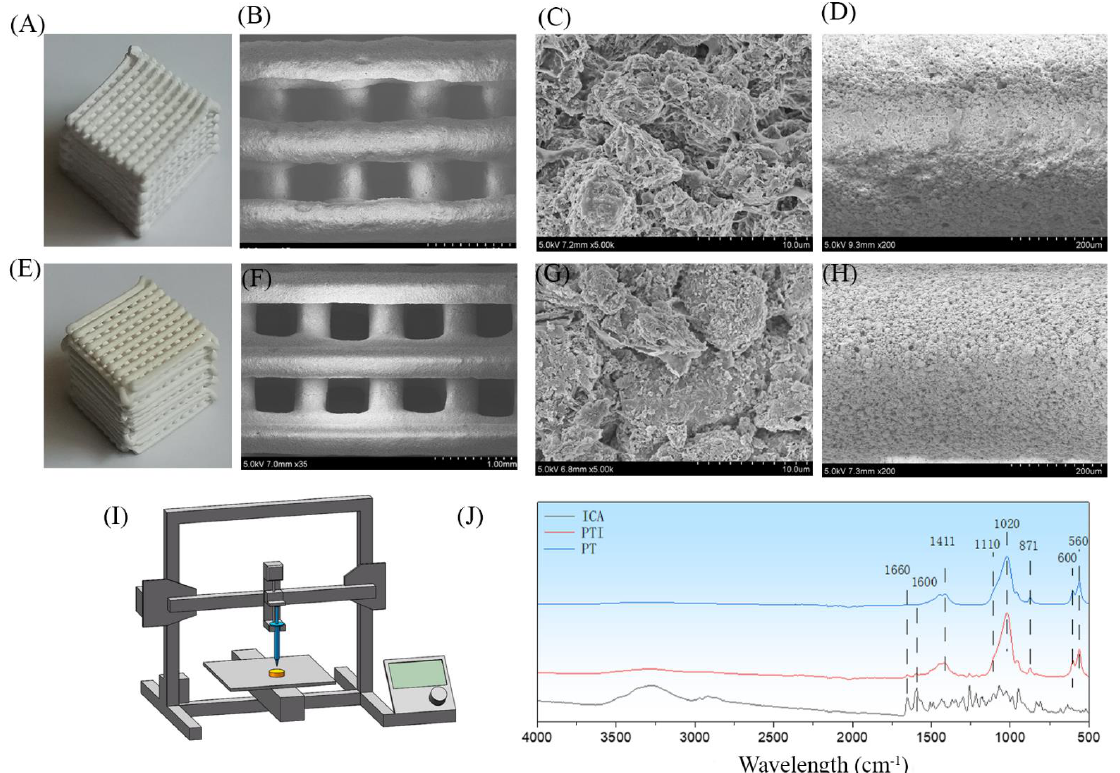
Figure 1. Physical appearance of scaffolds. Macroscopic photos and SEM micrographs of the PT ( A – D ) and PTI ( E – H ) composite scaffolds. High-resolution images of each category are provided as Supplementary Materials, File S1 ( I ). Three-dimensional printer schematic ( J ). FTIR was used to determine the surface chemical property of the scaffolds. The water contact angle experiment was used to measure the hydrophilicity of PT and PTI scaffolds. The water contact angles of the left and right sides of the PTI scaffold were 66.8° ± 1.4° and 68.4° ± 2.2°, respectively, which were significantly higher than those of the PT scaffold (36.3° ± 2.0° and 41.1° ± 4.8°) ( p < 0.001). This finding may be related to the poor solubility of ICA in water (Figure 2A,B). The pore of the PT scaffold was 462 ± 13 × 368 ± 20 µm 2 , which was not significantly different from that of the PTI scaffold (466 ± 12 × 358 ± 21 µm 2 ) ( p > 0.05), as shown in Figure 2C. The porosities of PT and PTI were 52.03% ± 2.12% and 51.26% ± 1.71%, respectively, exhibiting no statistical significance (Figure 2D).